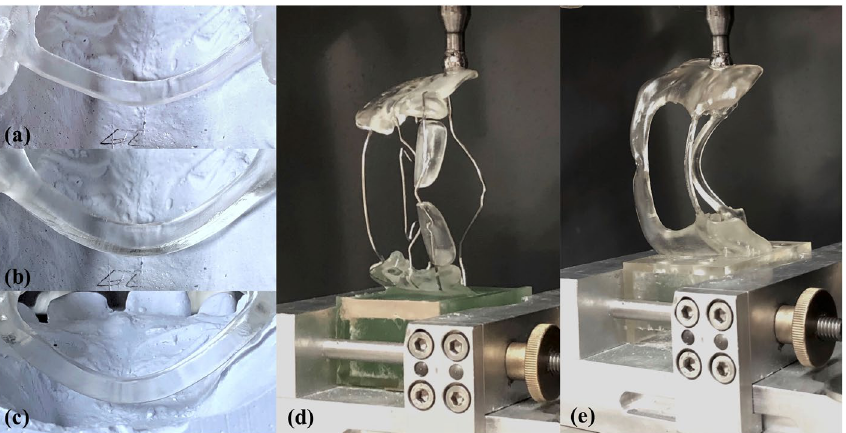
Figure 5. Transversal load testing of function regulator (FR3) designs. ( a – c ) CAD/CAM FR3s (CAD-FR3) were constructed with different palatal connector dimensions. Two connectors were constructed flat to the palate; one ( a ) had a width of 4 mm and a height of 1 mm (CAD-FR34 × 1) and the other one ( b ) had a width of 5 mm and a height of 2 mm (CAD-FR35 × 2). A third connector ( c ) was designed with a width and height of 3 mm (CAD-FR33 × 3). ( d , e ) All FR3 appliances underwent 1000 transversal load cycles at a load magnitude of 15 N before ultimate load testing was performed. Fmax(FR3) and stiffness values were compared among the different CAD-FR3 designs and conventional